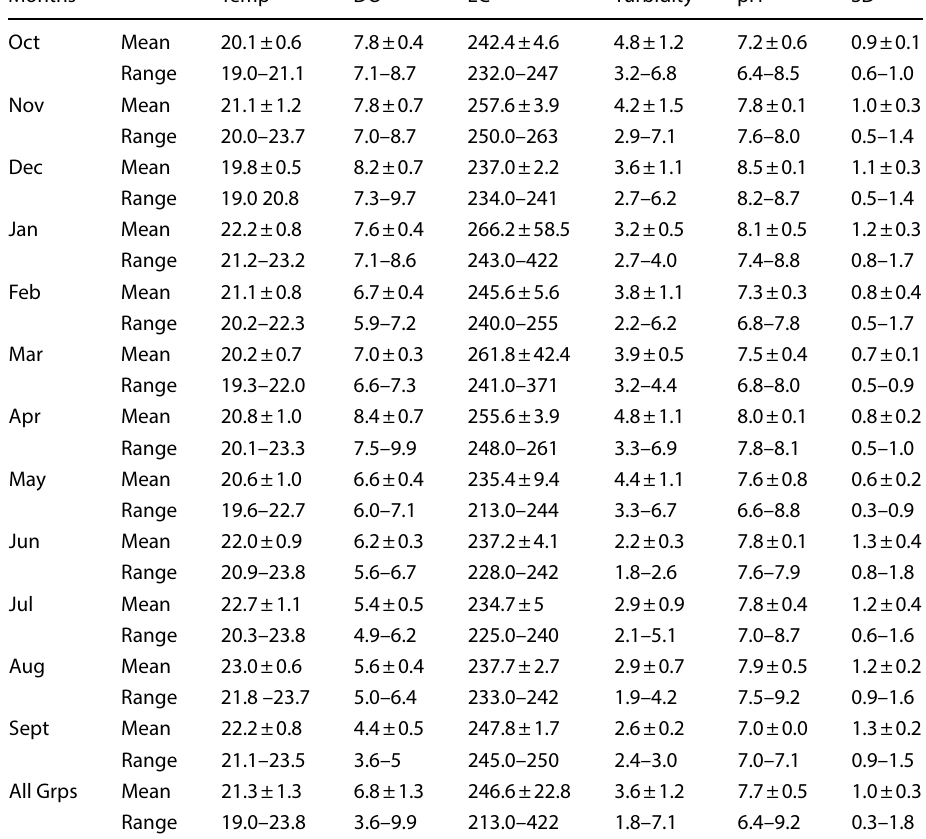
Table 5 Mean ± SD of physicochemical parameters in the different sampling months ( n =